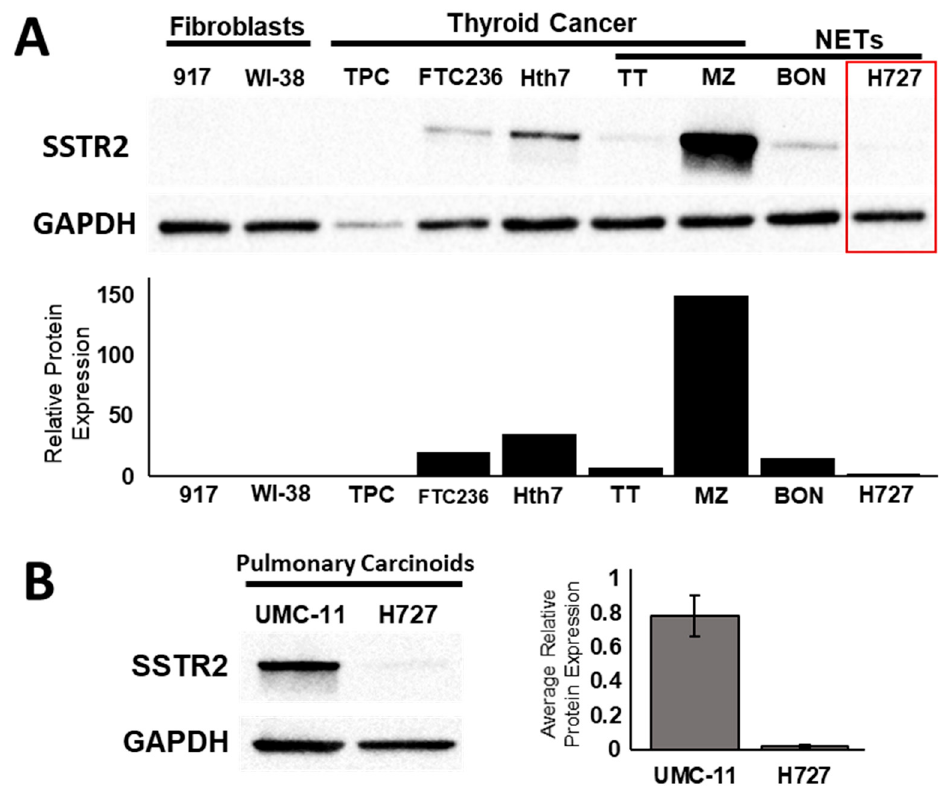
Figure 1. Basal levels of SSTR2 protein expression. ( A ) Basal expression level of SSTR2 in human fibroblast cell lines (917 and WI38), aggressive thyroid cancer cell lines (TPC, FTC236, and Hth7) and in neuroendocrine cancer cell lines (medullary thyroid cancer: TT and MZ; pancreatic NE cancer: BON; pulmonary carcinoid: H727). H727 cell line has the lowest basal expression of SSTR2 among all NET cells (Supplementary Figure S1). ( B ) A comparison of basal SSTR2 expression at the protein level between two pulmonary carcinoid cell lines: UMC-11 and H727 (Supplementary Figure S2). Error bars show standard deviation.